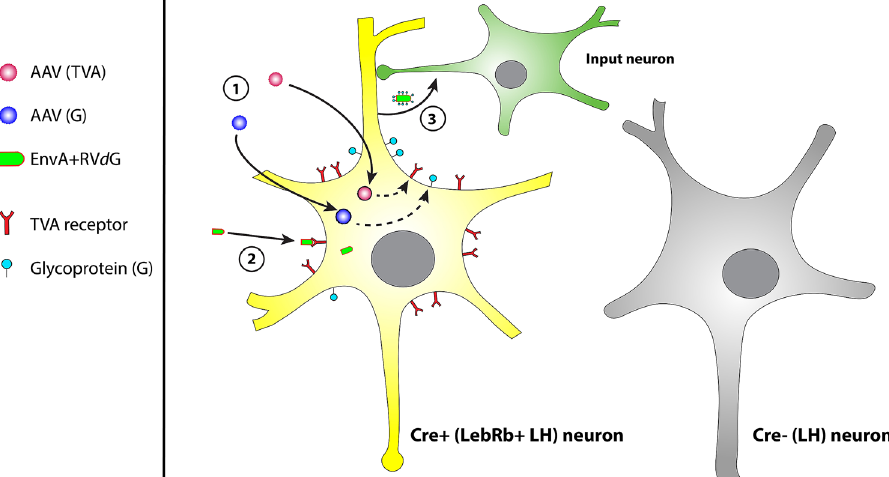
Figure 1. Working mechanism of modified rabies virus tracing technology. Modified rabies virus lacks the envelope protein G, which normally allows budding of new host cell-derived membrane-enveloped viral particles that have G on their membrane. Modified rabies is pseudotyped, so that it expresses EnvA as envelope protein. EnvA makes use of the avian-specific TVA receptor for entry in recipient cells. First (1), an injection with two helper AAV vectors delivers Cre-dependent TVA-mCherry and G in a mouse Cre-line. Only neurons that express Cre will start to express the TVA receptor and G. Second (2), when TVA and G are adequately expressed, mice are injected with modified G-deleted rabies virus (RV d G). EnvA-coated RV d G can only infect host-cells that express the TVA receptor and it needs host-cells to express G for trans -complementation in order to spread to presynaptic nerve terminals. Once EnvA-coated RV d G entered neurons via the TVA receptor, it replicates and uses G to obtain normal infectious properties. Thereby, it is able to spread monosynaptically